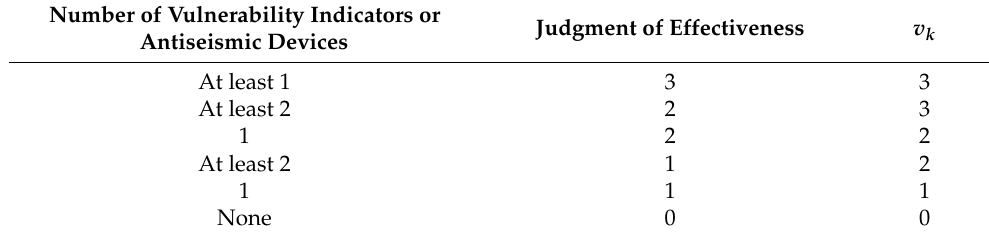
Table 6. Evaluation of the vulnerability modifiers (adapted from [4]). Number of Vulnerability Indicators or Antiseismic